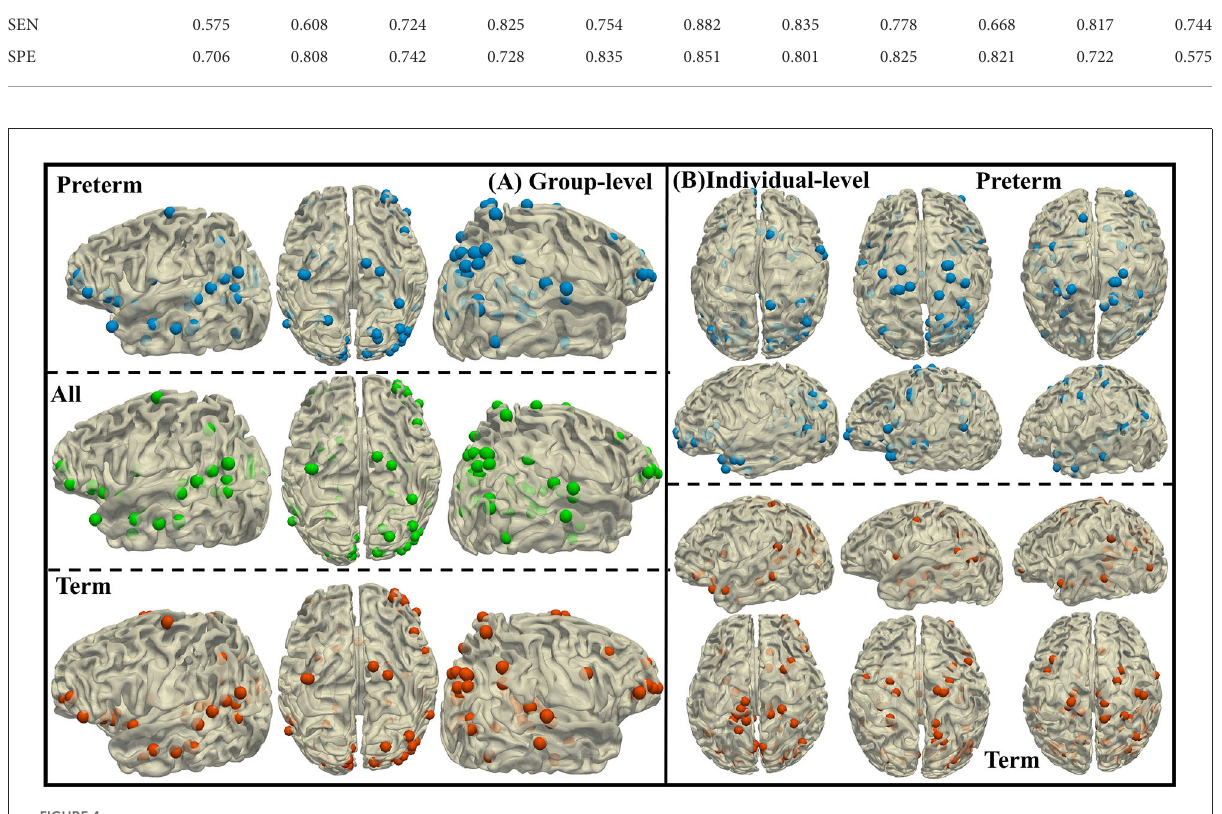
FIGURE4 (A) Visualize the important DICCCOL landmarks of preterm subjects, term subjects, and all the subjects on a random subject. (B) Visualize the important DICCCOL landmarks on preterm and term